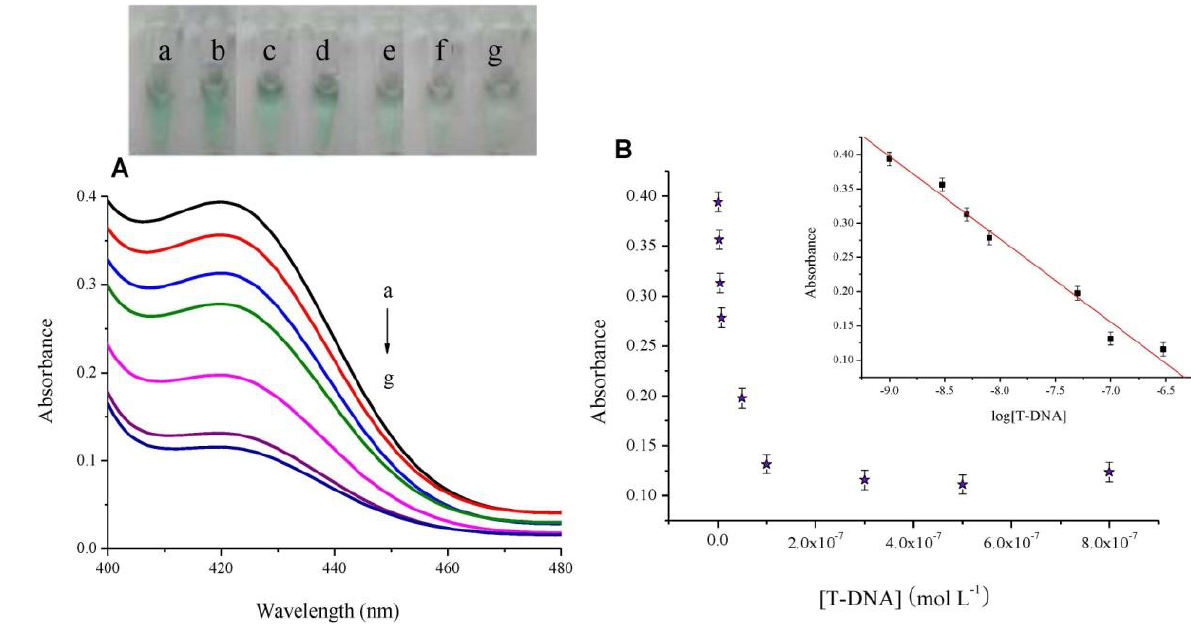
Figure 4. ( A ) Absorbance spectra of the H O mediated ABTS 2− colorimetric system with 2 2 probe-4 (1.0 × 10 −7 mol·L −1 ); T-DNA (a) 1.0 × 10 −9 ; (b) 3.0 × 10 −9 ; (c) 5.0 × 10 −9 ; (d) 8.0 × 10 −9 ; (e) 5.0 × 10 −8 ; (f) 1.0 × 10 −7 and (g) 3.0 × 10 −7 mol·L −1 . Inset: visual color changes of the systems with different concentrations of T-DNA. ( B ) Absorbance value at 419 nm of the colorimetric system with probe-4 (1.0 × 10 −7 mol·L −1 ) versus T-DNA